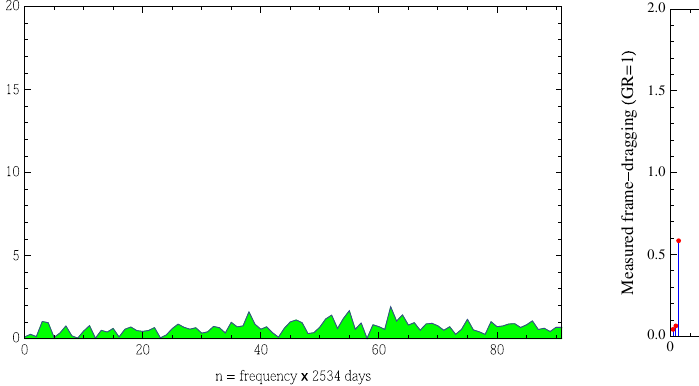
Fig. 6 Measurement of the Lense–Thirring effect using LARES, LAGEOS and LAGEOS 2 over increasing observational periods, i.e. each point of the curve was obtained by increasing the observational period of the previous point by 14 days, thus by increasing the total number of residuals by one with respect to the previous point. The curve clearly tends to its General Relativity value of 1 (normalized) well within the total systematic error of